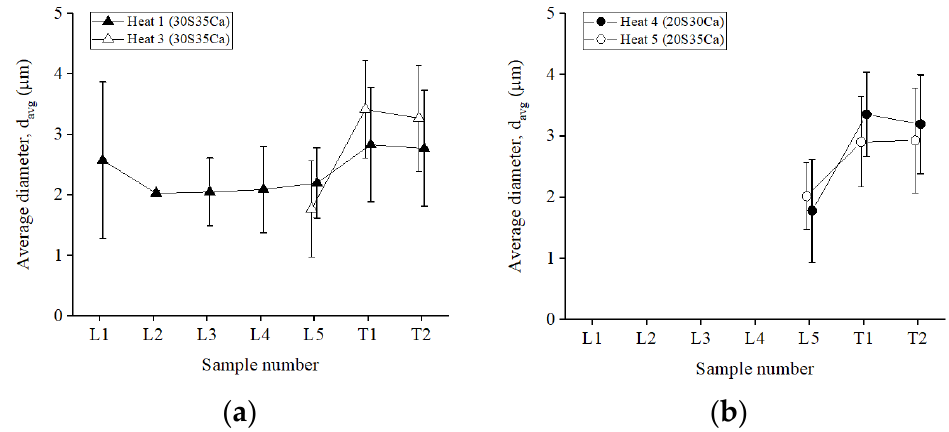
Figure 7. Evolution of the average diameters of CaS type inclusions in samples taken from ( a ) Heats 1 and 3–30 ppm S and 35 ppm T.Ca and ( b ) Heats 4 and 5–20 ppm S and 35 ppm T.Ca.